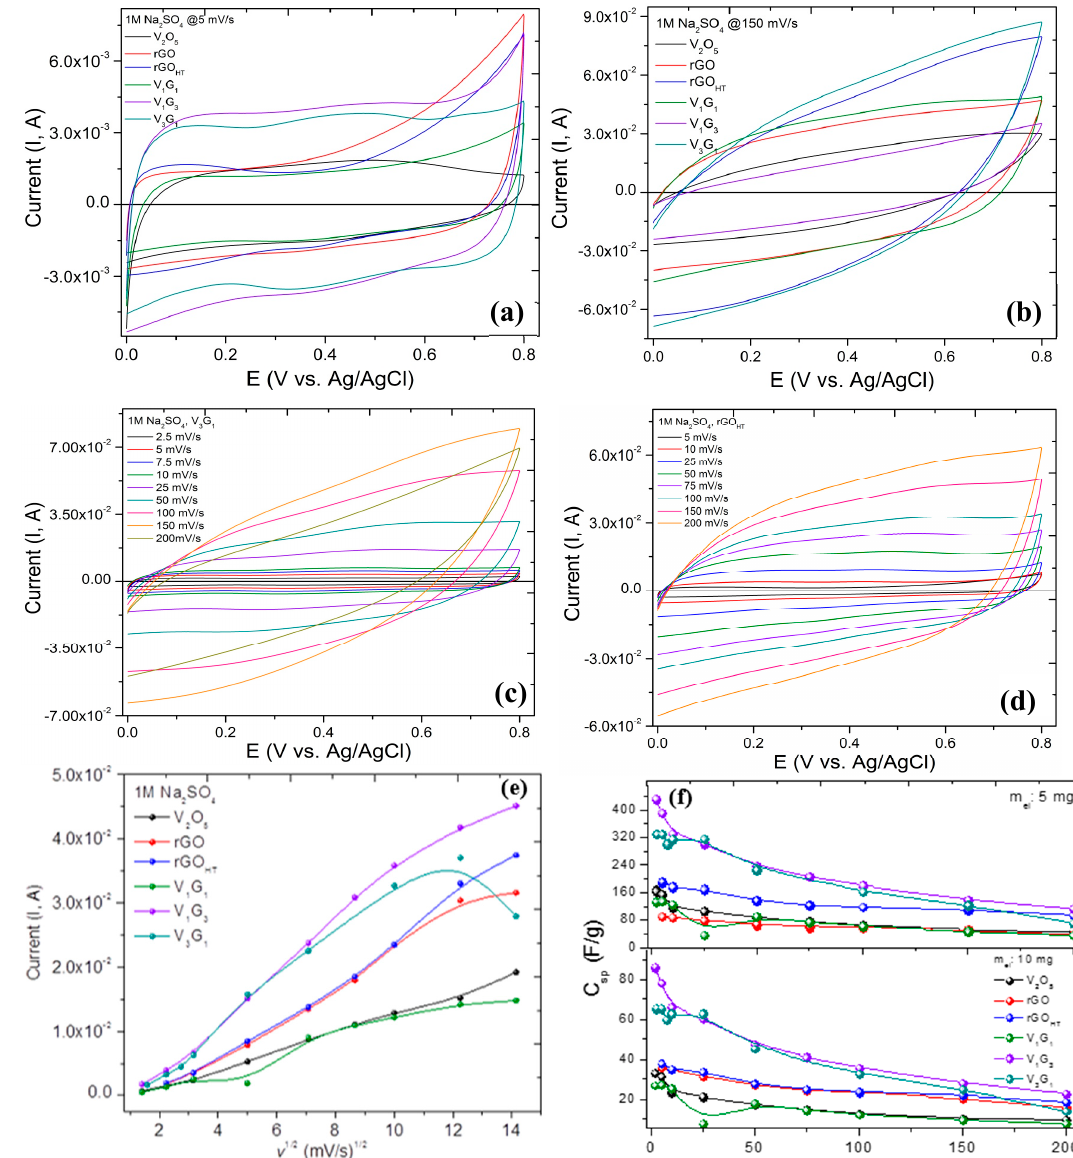
Figure 4. ( a – d ) Potentiodynamic (cyclic voltammetry; CV) mode showing quasi-rectangle behavior with redox peaks at a smaller scan rate; analyses in terms of ( e ) current versus sqrt scan rate and ( f ) gravimetric specific capacitance ( C sp ; F ∙ g − 1 ) with scan rate.